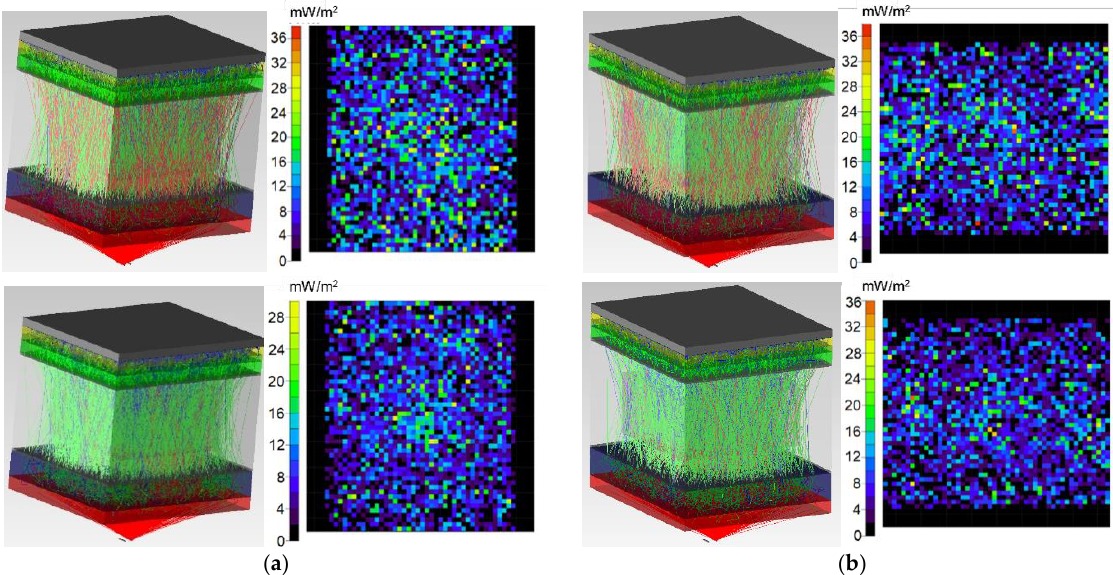
Figure 7. Simulation results for the probe radiation propagation through the maxillary sinus of female ( a ) and male ( b ) with cystic fluid at a wavelength of 650 nm ( top ) and 850 nm ( bottom ).